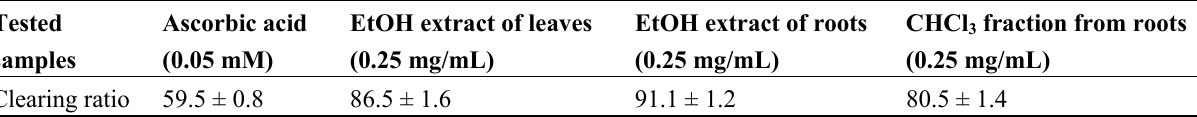
Table 2. Free Radical Scavenging Capacity of the